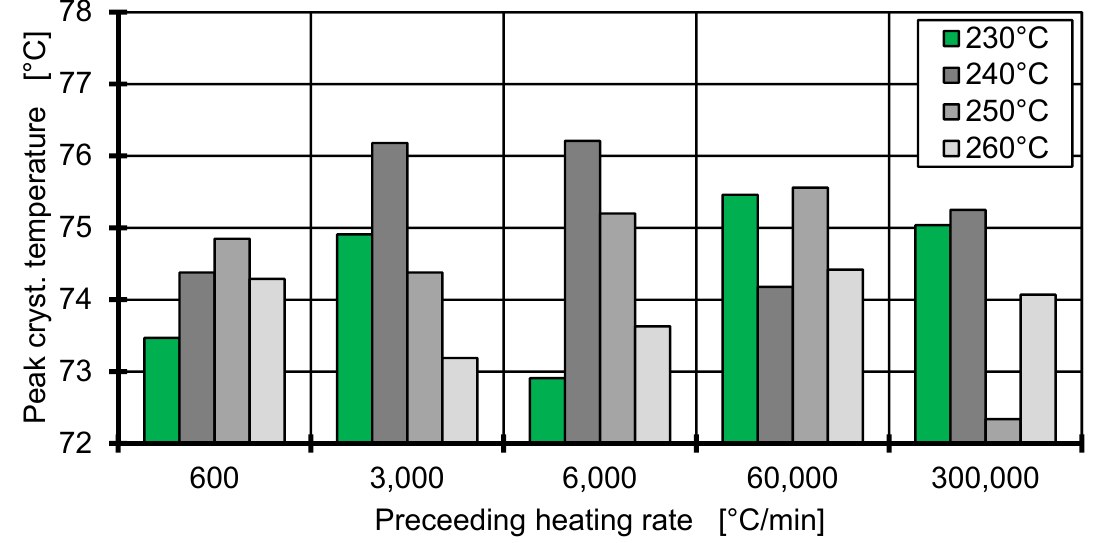
Figure 4. Peak crystallisation temperature at a cooling rate of 6000 °C/min with different starting temperatures and heating rates.